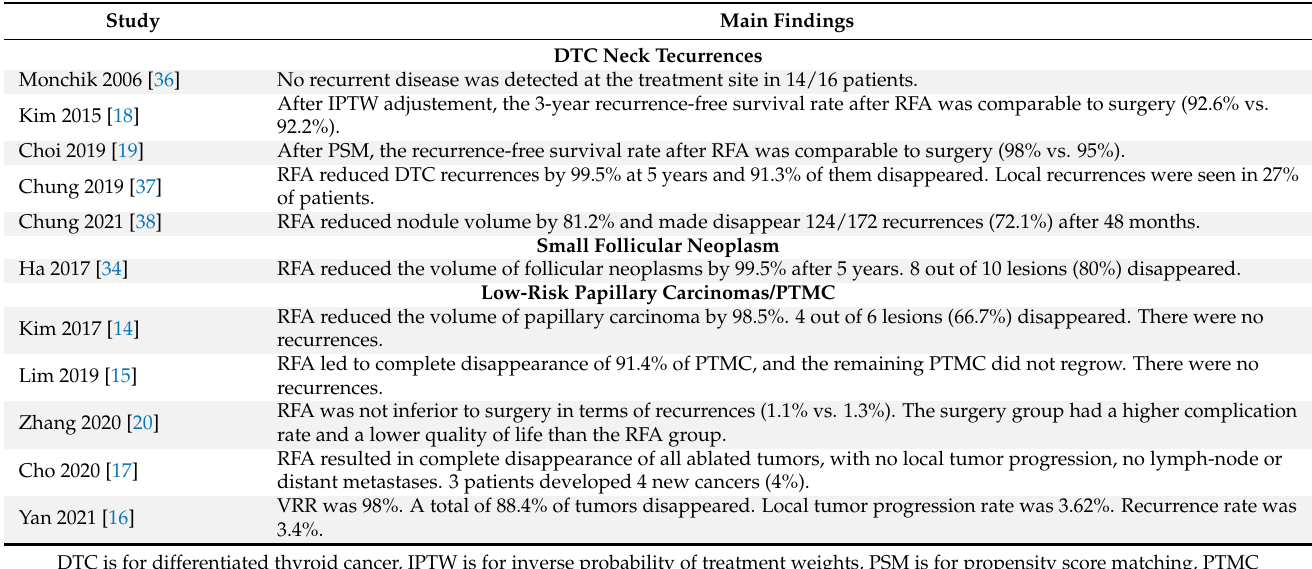
Table 3. Main findings of studies on RFA long-term outcomes in patients with malignant thyroid nodules. Study Main